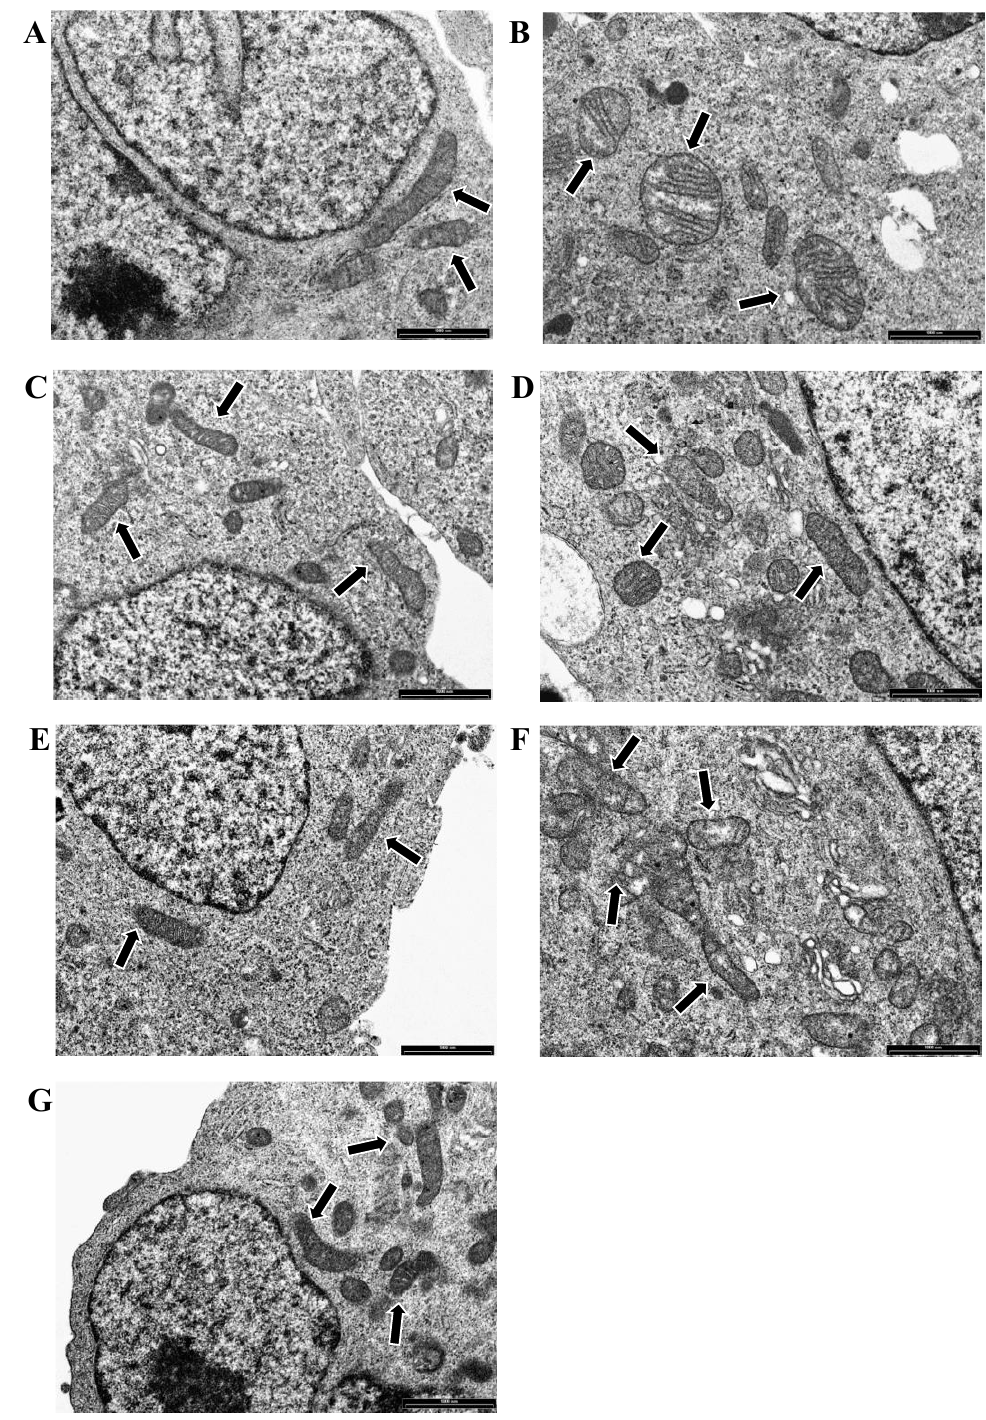
Figure 3. Representative transmission electron microscopy (TEM) images of CTR ( A ) and 6-OHDA- ( B ), EPA- ( C ), EPA + 6-OHDA- ( D ), DHA- ( E ), DHA + 6-OHDA- ( F ), and 5-AZA-treated ( G ) cells are reported. Mitochondria are highlighted with black arrows. Bars = 1000 nm.